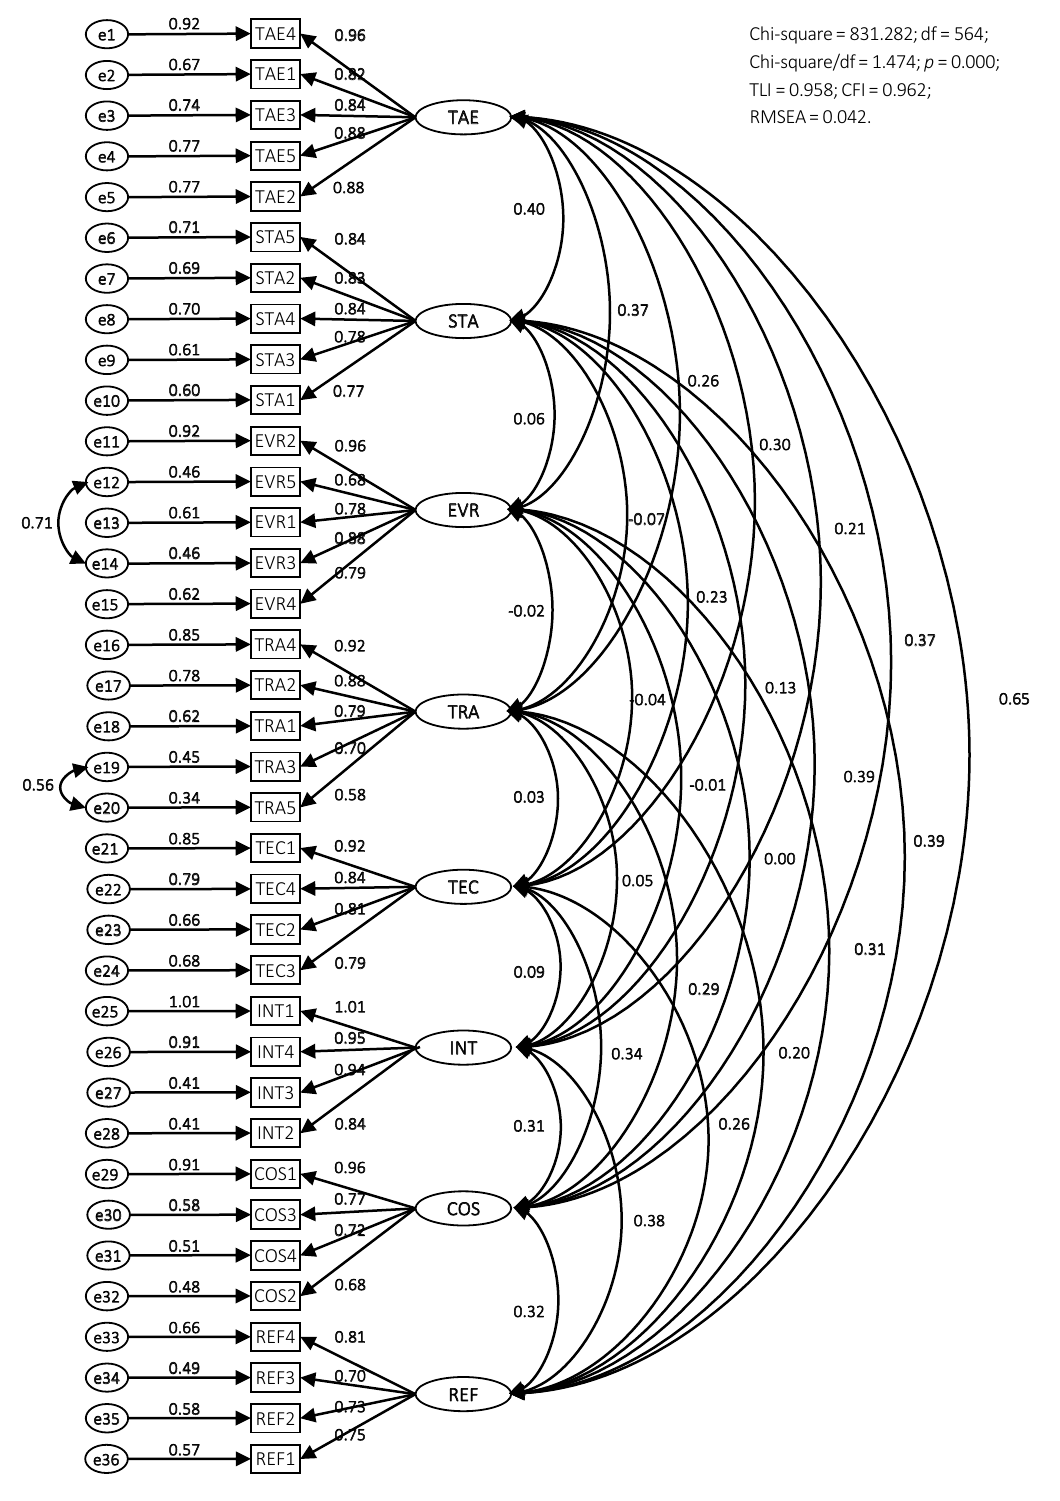
Figure 2. Testing of CFA (standardized